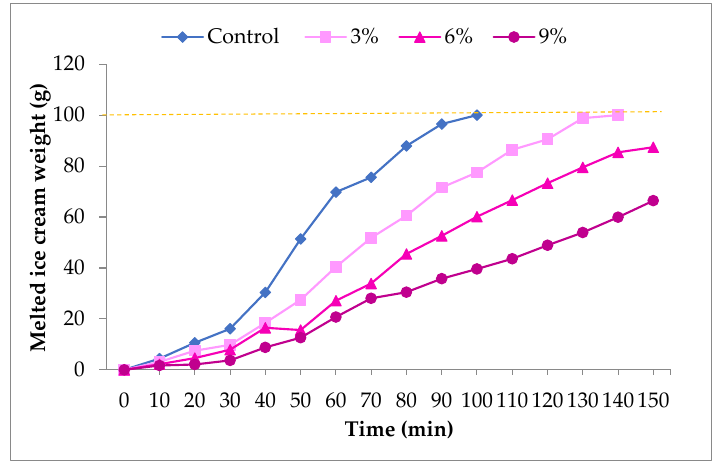
Figure 1. Melting behavior of probiotic ice creams supplemented with CCP.